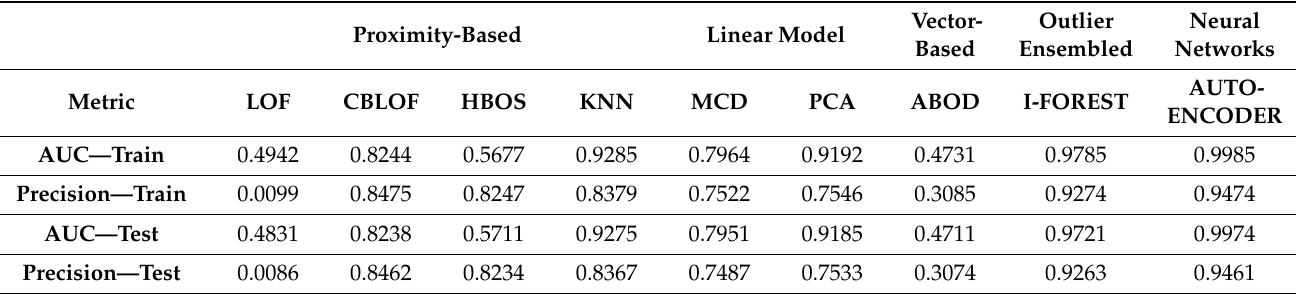
Table 1. Overview of Area Under the ROC (AUC) and Precision metrics (train and test data) for different algorithms.